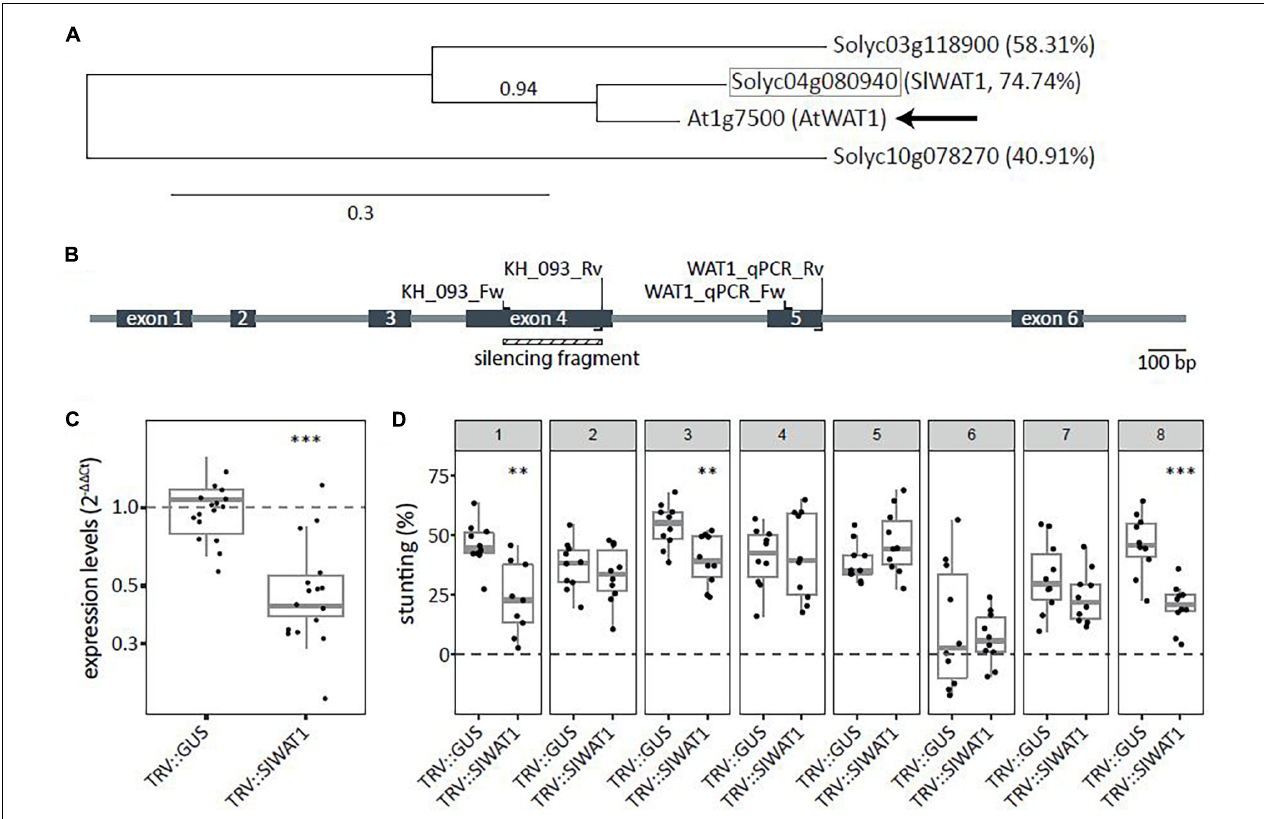
FIGURE 1 | Transient silencing of WAT1 in tomato resulted in reduced susceptibility to Verticillium dahliae . (A) Phylogenetic tree based on amino acid sequences for WAT1 including potential ortholog from tomato (highlighted in gray square). Percentages indicate protein sequence similarity to AtWAT1 marked with an arrow. Number above node indicate branch support values. (B) Schematic overview of SlWAT1 (Solyc04g080940) with intron/exon locations as well as primers for cloning the VIGS fragment and for monitoring the SlWAT1 expression. (C) Expression levels (2 − (cid:49)(cid:49) Ct ) of plants treated with TRV::SlWAT1 in stems normalized to TRV::GUS 2 weeks after Agrobacterium tumefaciens treatment on a log10 scale. Data of two independent experiments with n ≥ 6 per experiment per genotype ( t -test when compared with TRV::GUS with ∗∗∗ p < 0.001). (D) Stunting (%) in Verticillium dahliae -inoculated plants when compared with the average of mock-inoculated plants at 21 dpi after transient silencing of SlWAT in eight independent experiments with n ≥ 8 per experiment per genotype ( n ≥ 8, t -test when compared with TRV::GUS with ∗∗ p < 0.01 and ∗∗∗ p <